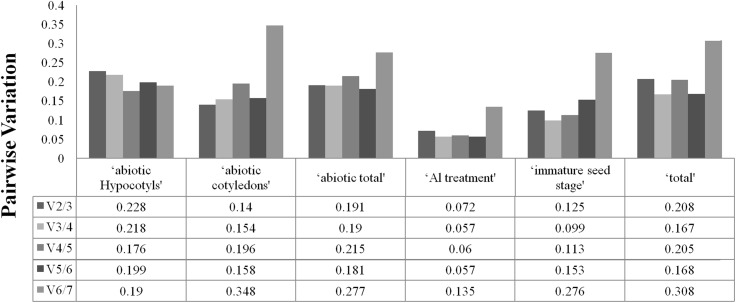
Optimal number of reference genes required for accurate normalization entile.